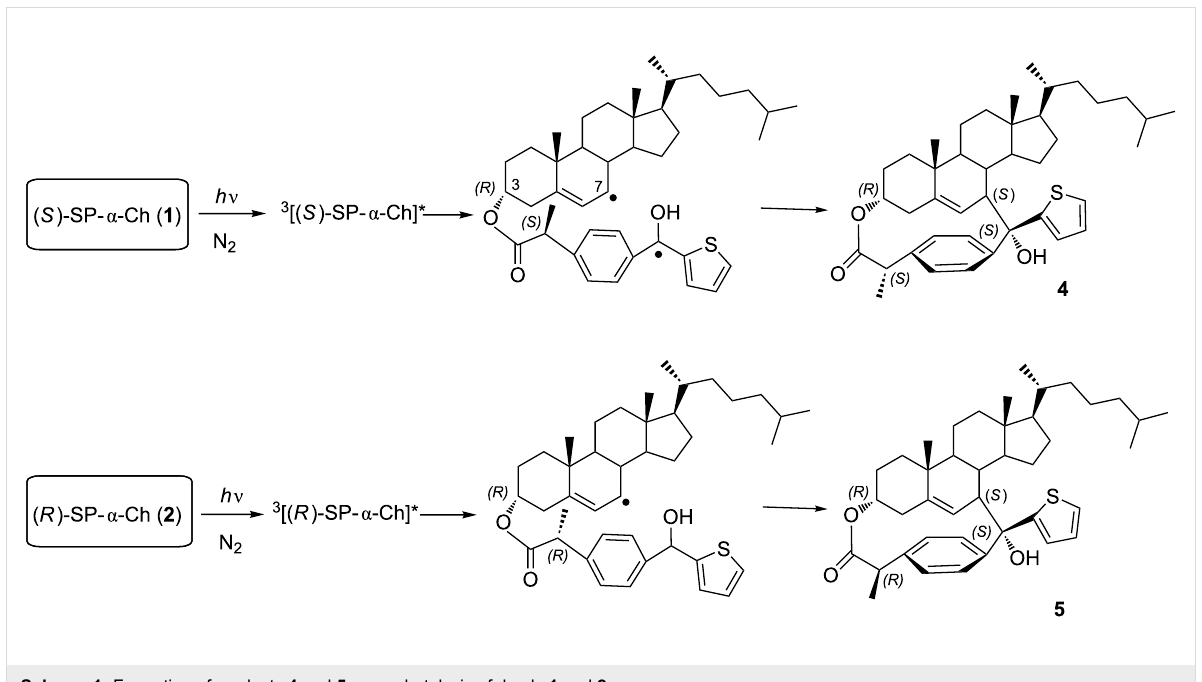
Scheme 1: Formation of products 4 and 5 upon photolysis of dyads 1 and 2 .